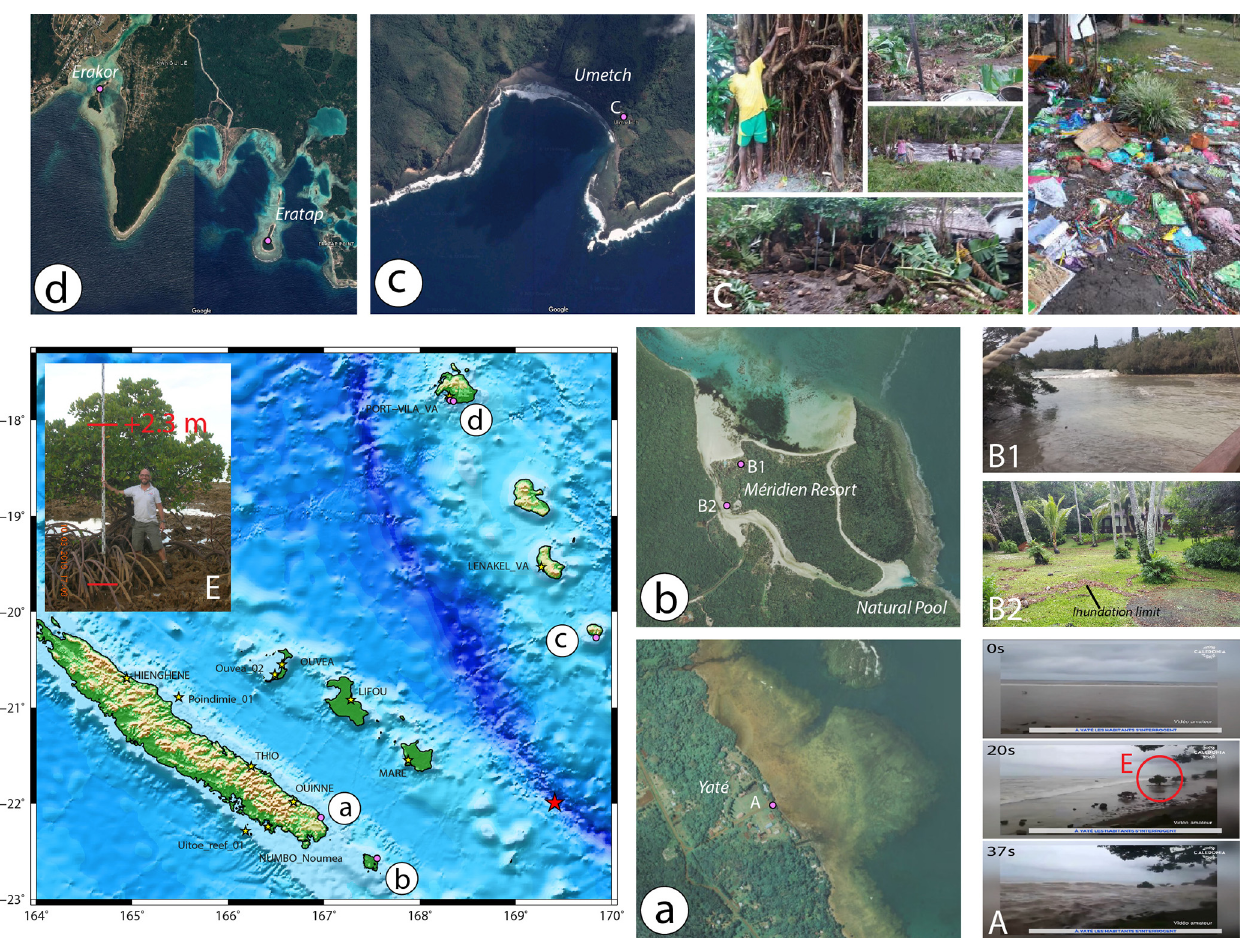
Figure 4. Observations of the tsunami arrival and height in several places in New Caledonia and Vanuatu. (a) Yaté; (b) Pine Island – Le Méridien resort; (c) south Aneityum; (d) south of Port Vila, south Efate. (Photo credits – a, b : © Georep New Caledonia 2021; c, d : © Google Earth 2021 – CNES/Airbus; A : Caledonia TV; B1, B2 : Moana Bretault; C : Vanuatu Meteorology and Geohazards Department; E :